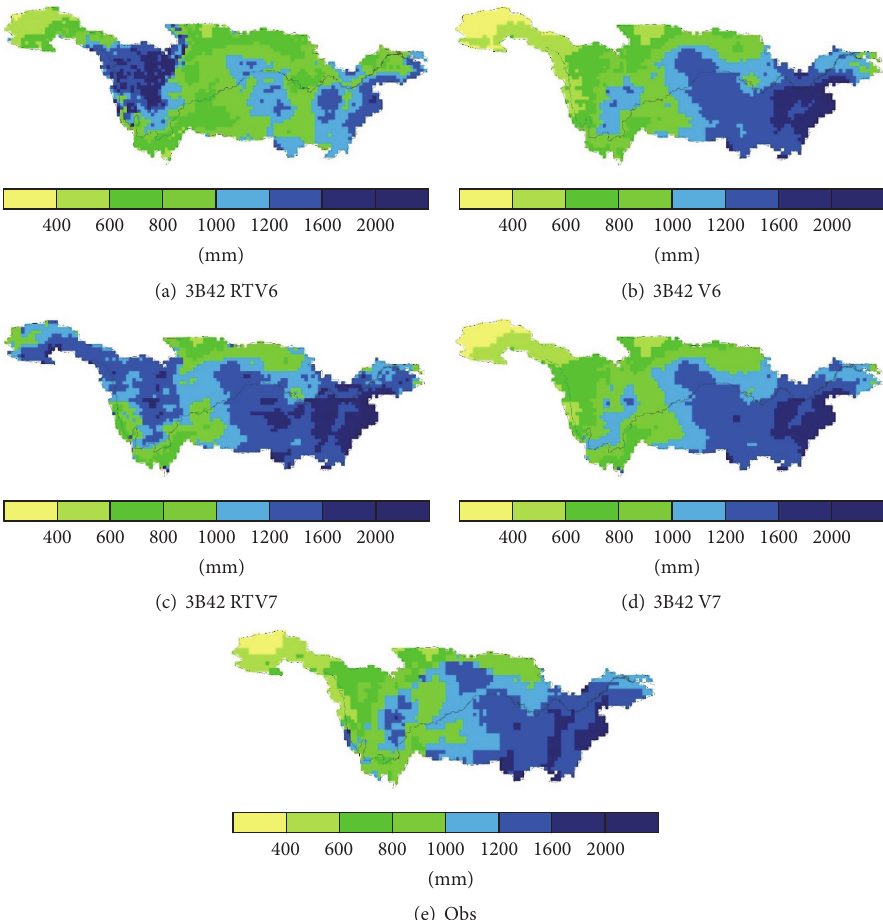
Figure 2: Spatial distribution of average annual precipitation in Yangtze River basin for the TMPA and observed data from 2003 to 2010. Table 1: Distributions of Bias for rainfall estimates from TMPA in the upper Yangtze, mid-lower Yangtze, and the entire Yangtze (Unit: %). Area